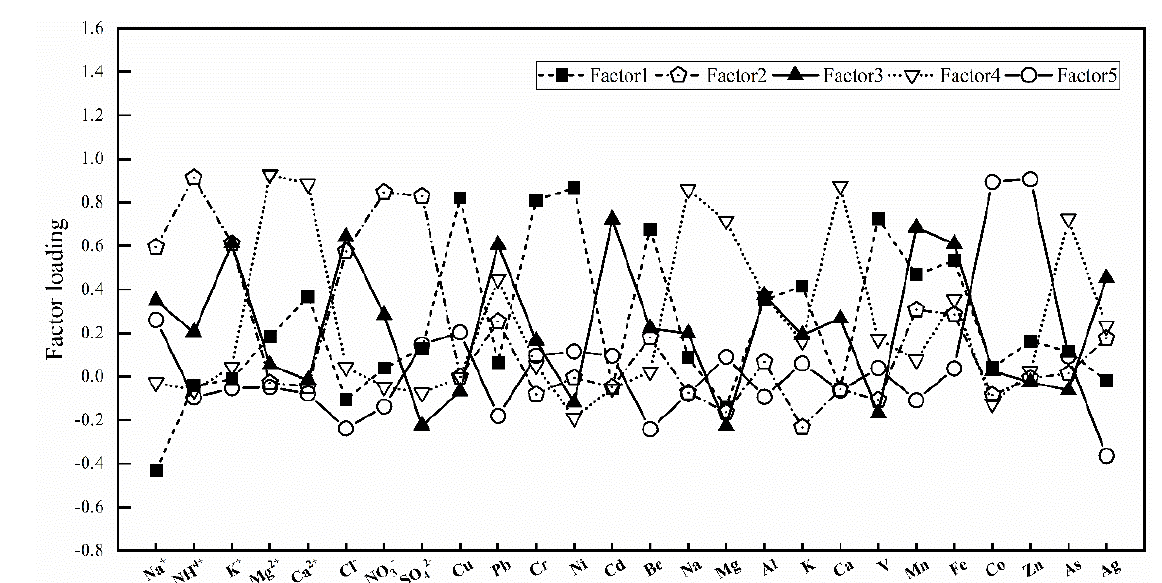
Figure 6. Diagram of maximum variance rotation factor analysis. Na + , sodium ion; NH 4+ , ammonium ion; K + , potassium ion; Mg 2+ , magnesium ion; Ca 2+ , calcium ion; Cl − , chloride ion; NO 3 − , nitrate; SO 42 − , sulfate; Cu, copper; Pb, lead; Cr, chromium; Ni, nickel; Cd, cadmium; Be, beryllium; Na, sodium; Mg, magnesium; Al, aluminum; K, potassium; Ca, calcium; V, vanadium; Mn, manganese; Fe, iron; Co, cobalt; Zn, zinc; As, arsenic; Ag, silver. Table 1. Related parameters of population exposure evaluation model.